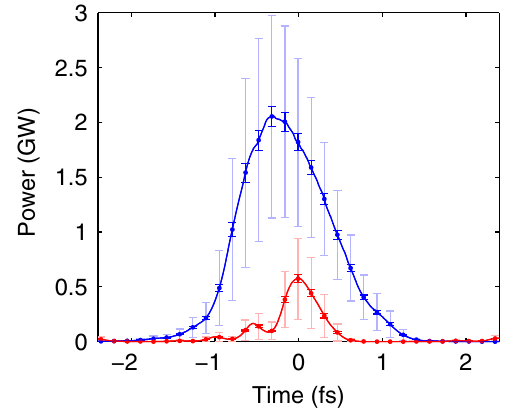
FIG. 4. Power at saturation for the 1600 and 800 nm slicing laser wavelength options. Bold error bars show the error on the mean value; faint error bars show standard deviation over 100 shot-noise